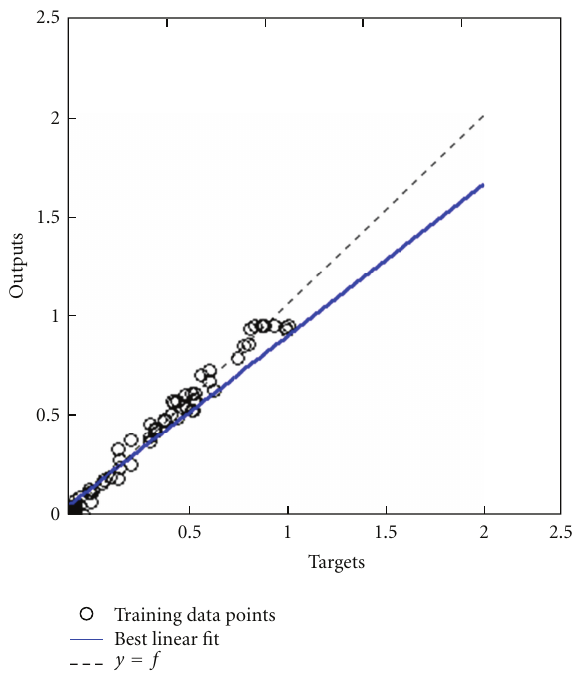
Figure 4: Training outputs versus targets with correlation factor R = 0 .